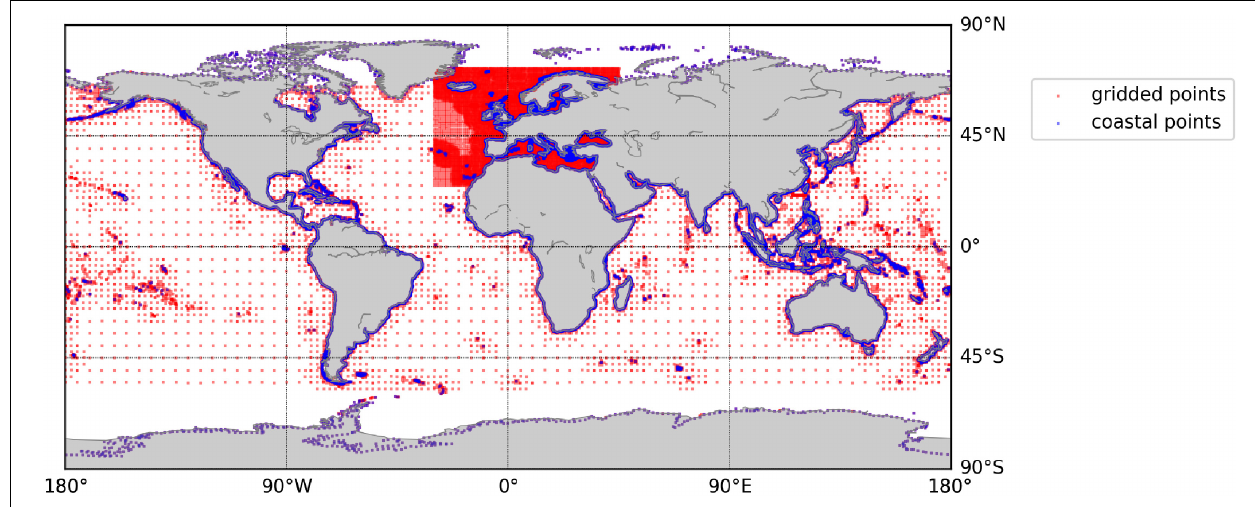
FIGURE 1 | Overview of the output locations used for the CoDEC dataset, including the coastal locations, tide gauge stations, and gridded points.